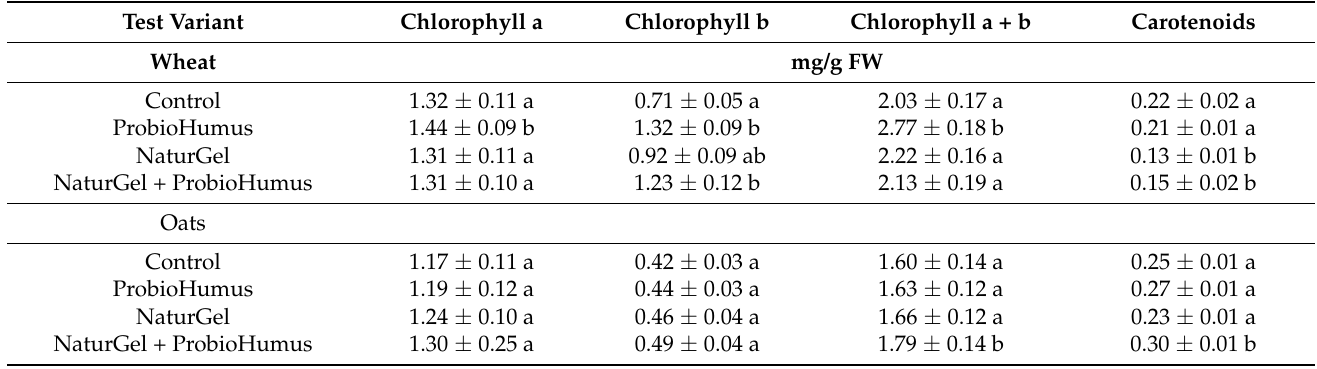
Table 3. Effect of ProbioHumus and NaturGel on pigment accumulation in wheat and oat leaves at the beginning of stem elongation.